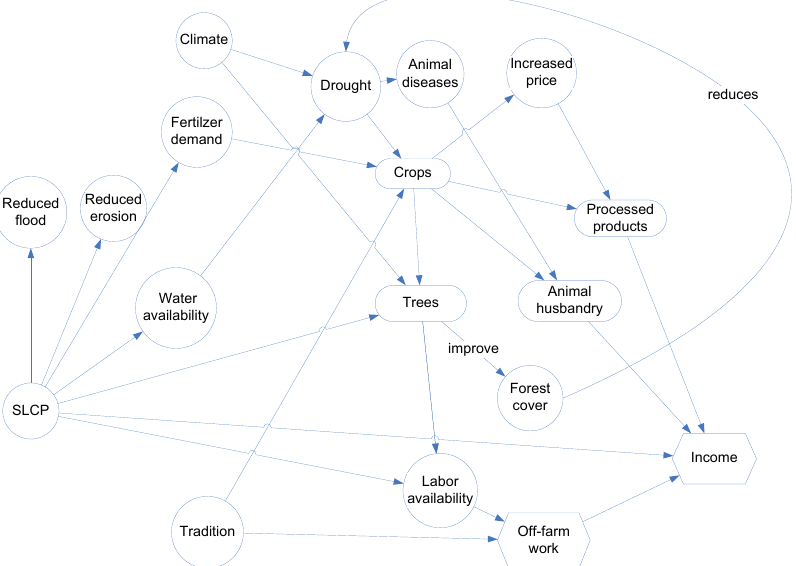
Figure 2. Example of the concept map for the village of Zi based on the group